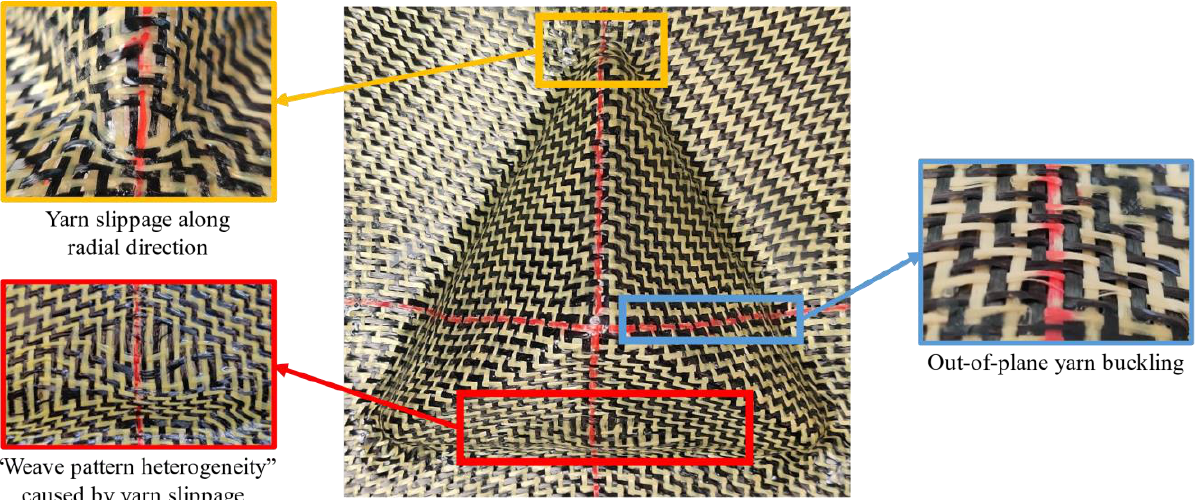
Figure 17. The preforms shape obtained from a tetrahedron preforming under high blank holder pressure (4 Kpa). Excessive yarn tension leads to more serious yarn slippage along the radial direction, but out-of-plane yarn buckling does not disappear.